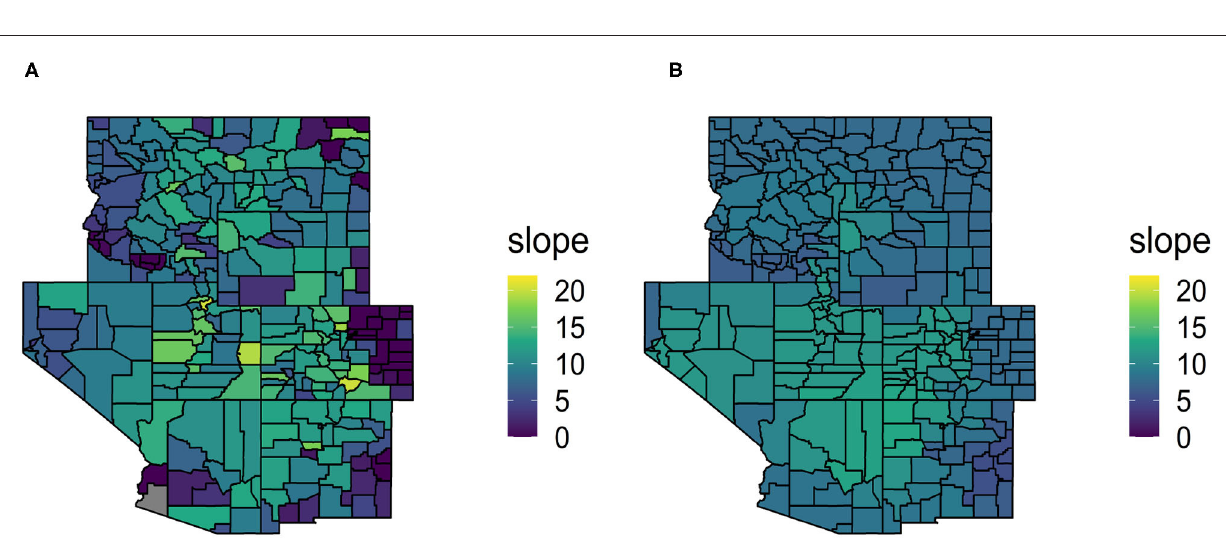
FIGURE 5 | Map (A) contains the estimated slopes of the linear regression model of trees per acre based on TCC for each county in the GREG when the models are fit at the county level. Map (B) contains the estimated slopes for each county in the GREGORY when the models are fit at the province